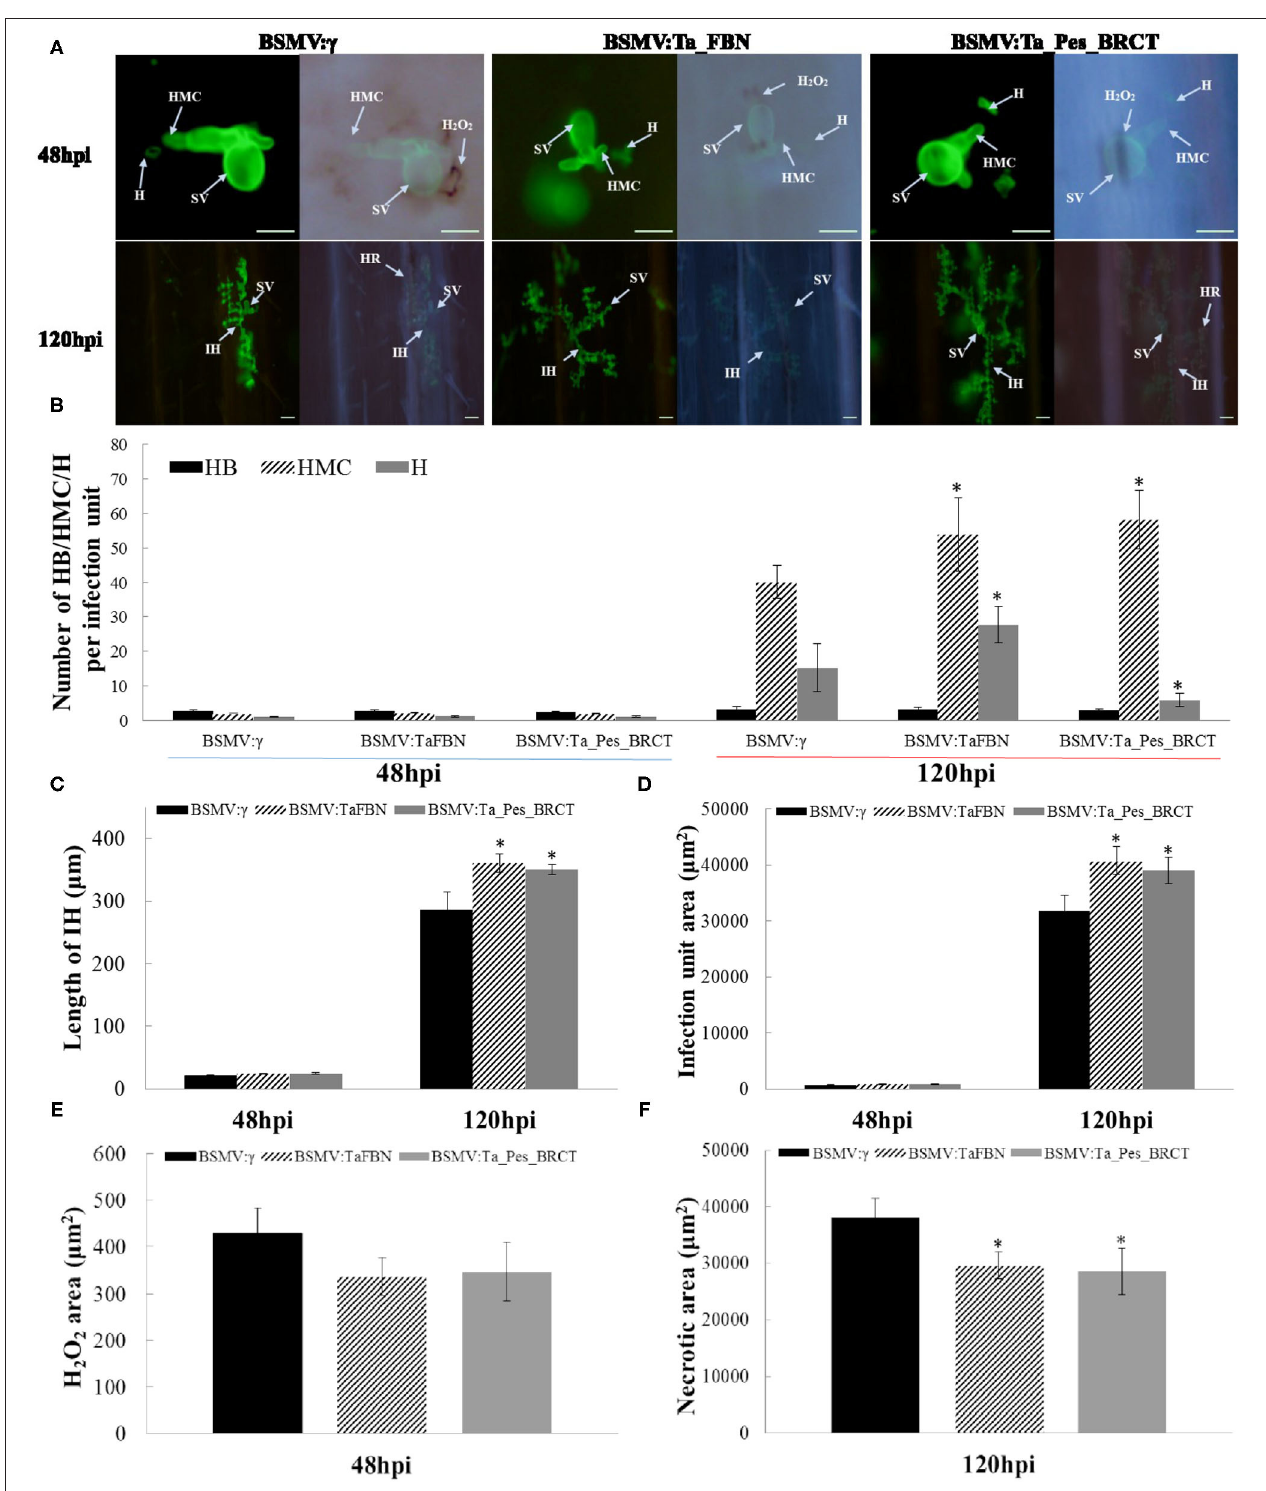
FIGURE 4 | Histological observations of Pst race CYR33 infection in TaFBN-knockdown and Ta_Pes_BRCT-knockdown wheat plants. (A) WGA was used to stain the leaves to visualize pathogens. (B) Number of HB/HMC/H; (C) length of IH; (D) infection unit area; (E) H 2 O 2 area; and (F) necrotic area staining by 3,3 ′ -diaminobenzidine (DAB) were measured with DP-BSW software in TaFBN -knockdown plants at 48 and 120 hpi after inoculation. SV, substomatal vesicle; IH, initial hyphae; HMC, haustorial mother cell; SH, secondary hyphae. Error bars represent the standard deviations of three independent samples. The significance of differences is indicated by asterisks and tested using Student’s t -test ( P < 0.05). Bar, 50 µ m.